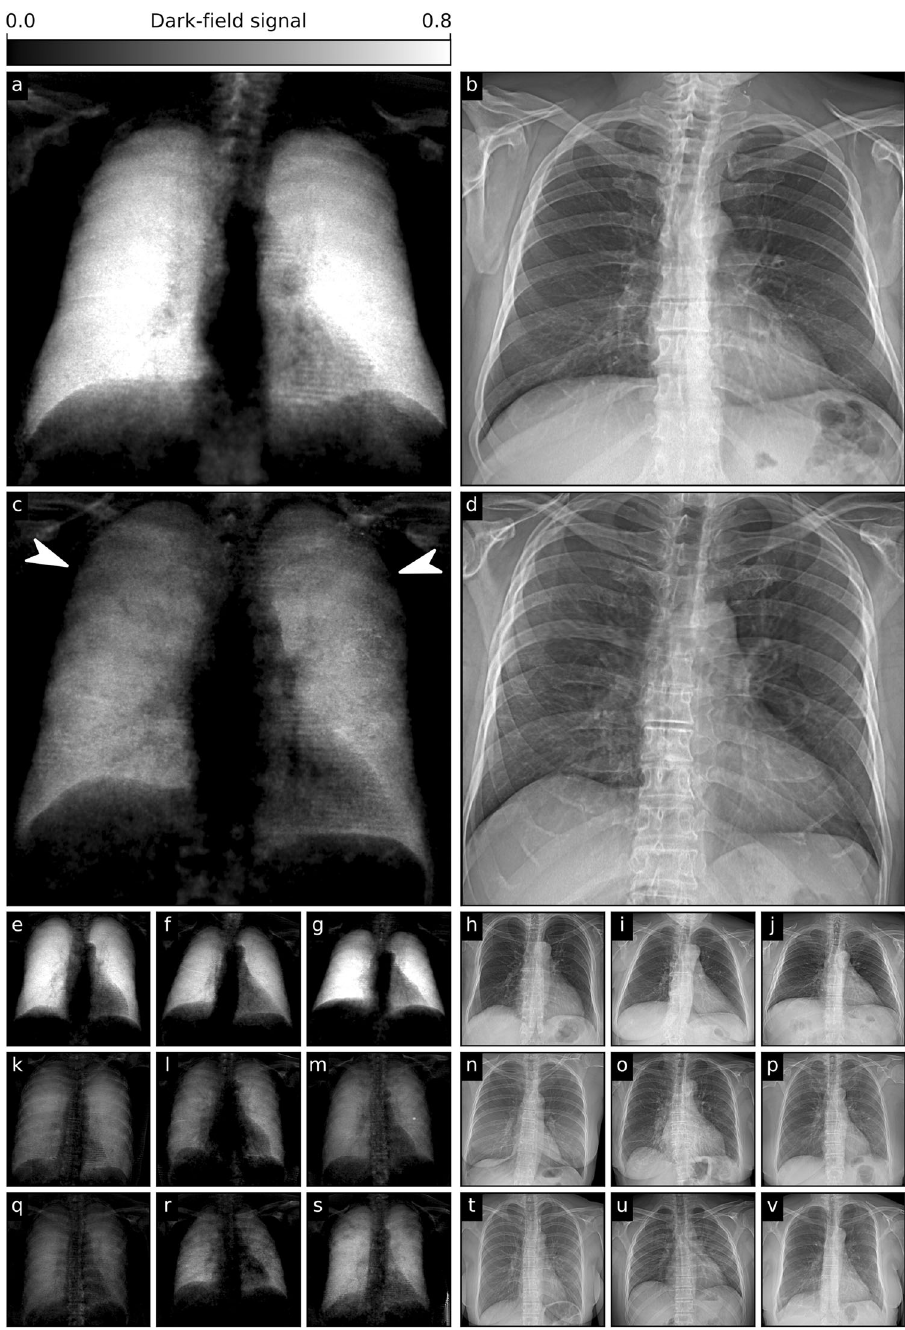
Fig. 4 Dark- fi eld and conventional chest X-rays of healthy and COVID-19-infected subjects. a Dark- fi eld and b conventional (attenuation-based) chest radiographs of a healthy subject. The dark- fi eld radiograph exhibits a strong, homogeneous dark- fi eld signal. The respective attenuation-based image shows no apparent pathology. c Dark- fi eld and d attenuation-based chest radiographs of a patient infected with COVID-19. Compared to the healthy subject, the infected patient shows an overall decrease of signal intensity. While the signal of the healthy subject is homogeneous, the dark- fi eld signal of the infected patient appears inhomogeneous and patchy, especially in the periphery of the lung (arrowheads). e – g Additional exemplary dark- fi eld radiographs of healthy subjects, h – j , respective attenuation-based radiographs. k – v More exemplary dark- fi eld and respective attenuation-based images of patients infected with COVID-19. k – m , Dark- fi eld images with a generally reduced signal intensity. q-s , Dark- fi eld images with a rather inhomogeneous, patchy texture, predominantly in the periphery. n – p and t – v respective attenuation-based images in comparison, in which it is rather dif fi cult to impossible to detect combination of both ( p < 0.05 for all) (Fig. 5a). Overall rating (3.16 ± 1.46). Additionally, rating values for infected patients were values for the presence of COVID-19-pneumonia in infected higher for the combination of dark- fi eld-based and (conven- patients were substantially higher for dark- fi eld imaging tional) attenuation-based imaging (5.04 ± 1.37) compared to (4.84 ± 1.39) compared to attenuation-based imaging dark- fi eld-based imaging alone. In a ROC analysis for the